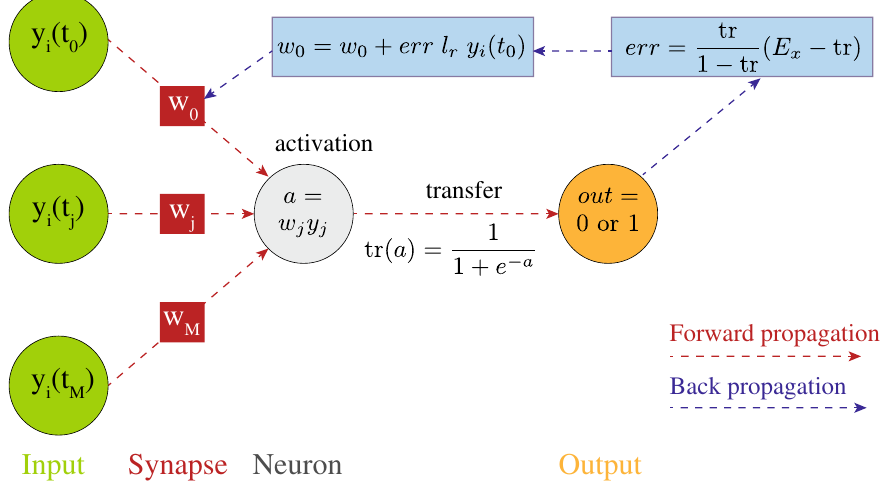
Figure 4. Artificial Neural Network used to classify trajectories, using a feedforward and back propagation training method. The network is comprised of a single neurone and several synapses whose weight w evolves during the training to optimise the network prediction. The cycle shown corresponds to one training epoch